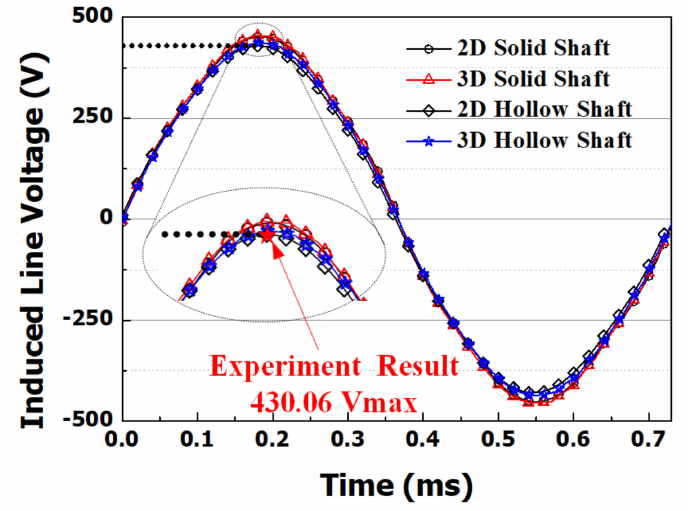
Figure 11. Line voltage at no-load condition. Table 6. Comparison of electromagnetic characteristics obtained using FEM analysis and experiment. Back EMF Characteristic (Vrms)